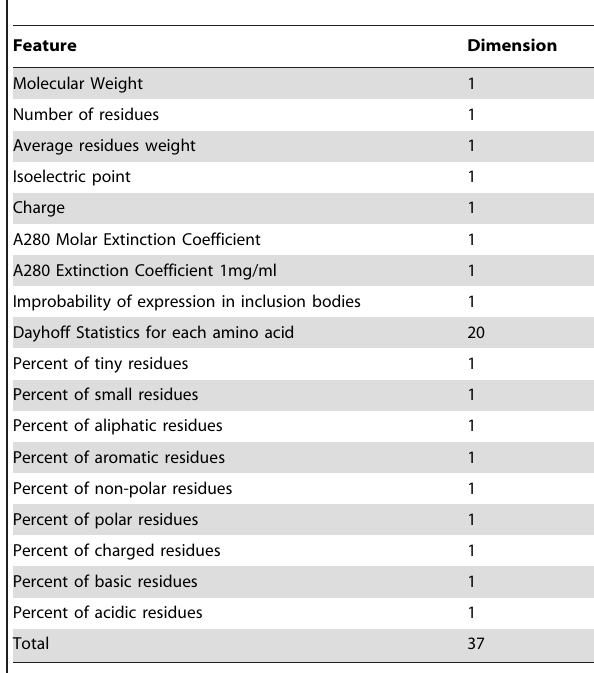
Table 2. Features used in Pepstats-SVM and their